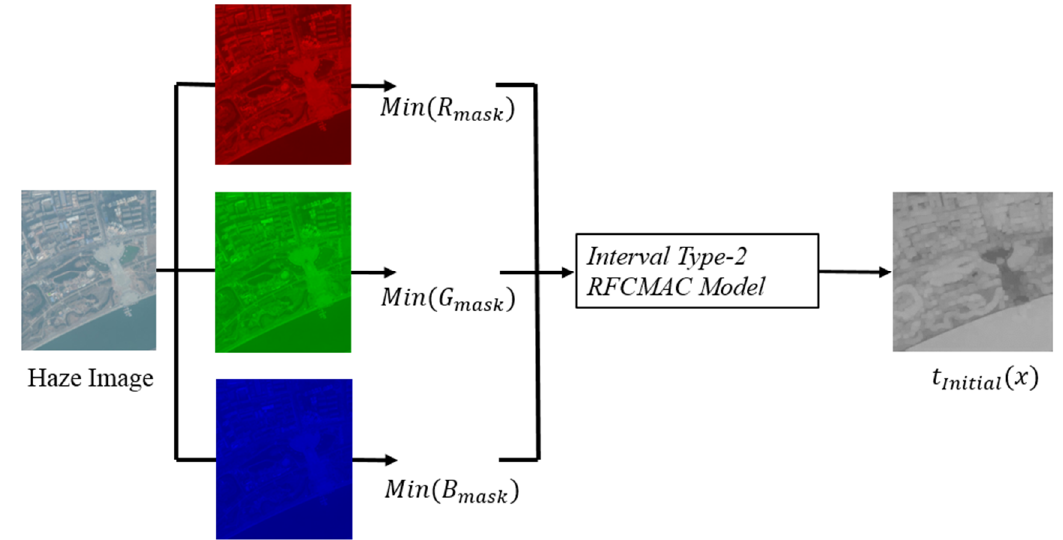
Figure 3. Initial transmission map estimation using the IT2RFCMAC model.